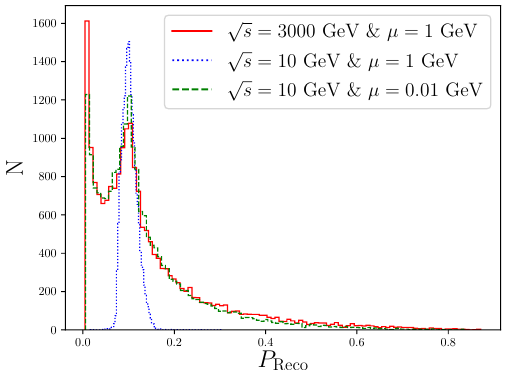
p s = 3000 GeV and